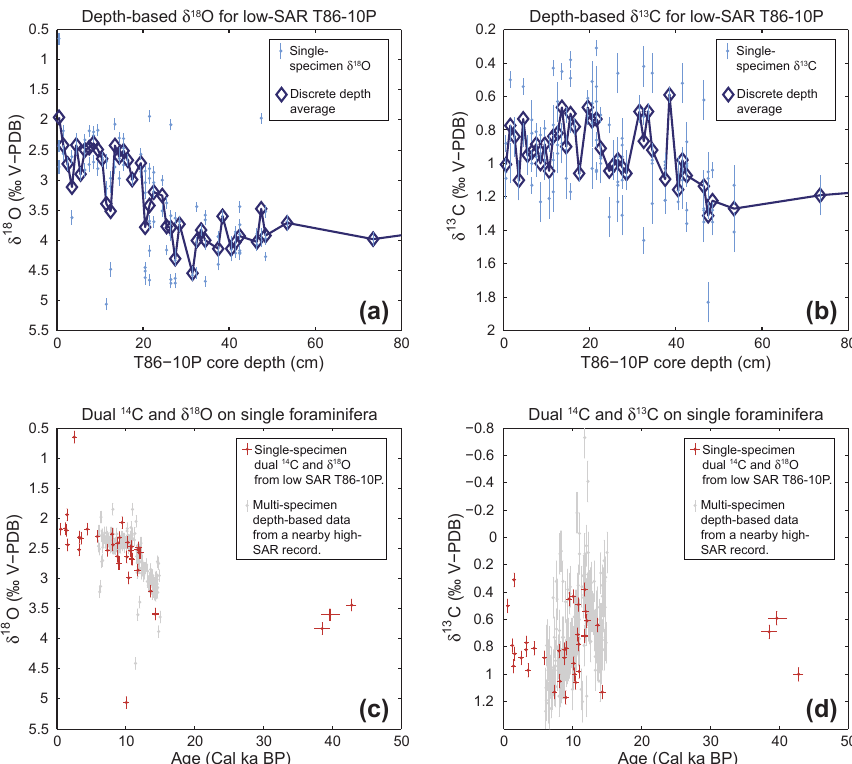
Figure 5. Demonstration of the successful use of dual 14 C and stable isotope analysis on single foraminifera to retrieve useful paleoclimate information from the low-SAR core T86-10P. (a) Firstly, to visualise the inability to retrieve useful glacial–interglacial paleoclimate data from the low-SAR core T86-10P using long-standing geochronological methods, we show single-specimen C. wuellerstorfi δ 18 O data against core depth (with 1 σ measurement error). Also shown is the average δ 18 O value of the single specimens for each discrete sediment core depth analysed (i.e. imitative of long-standing methods using multi-specimen samples). (b) Same as for (a) , but with δ 13 C instead of δ 18 O. (c) Successful dual 14 C and δ 18 O measurements on single foraminifera from core T86-10P. Vertical error bars denote 1 σ error measurement. Horizontal error bars denote the 68.27% highest posterior density (HPD) interval of the calibrated 14 C age (see the “Method” section for 14 C calibration process). Also shown are previously published multi-specimen δ 18 O data from a nearby high-SAR (20cmka − 1 ) record (Repschläger et al., 2015). Vertical error bars represent 1 σ measurement error. (d) Same as for (c) , but with δ 13 C instead of δ 18